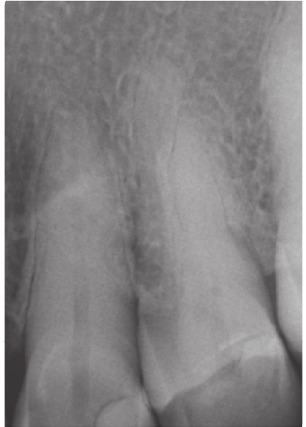
Figure 2: Intraoral radiograph of the